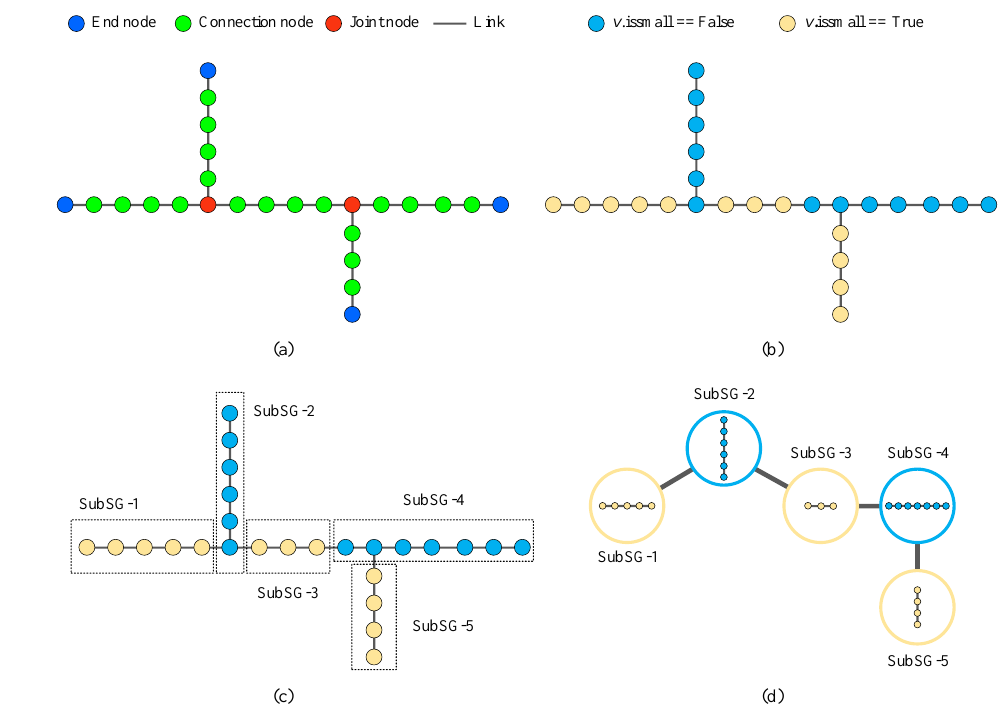
Figure 3. Progressive pre segmentation of the river segment based on the skeleton graph: ( a ) example of skeleton graph; ( b ) labelling the node attribute issmall of the skeleton graph; ( c ) skeleton graph segmentation subgraph; and ( d ) subgraph abstraction result of the skeleton graph.